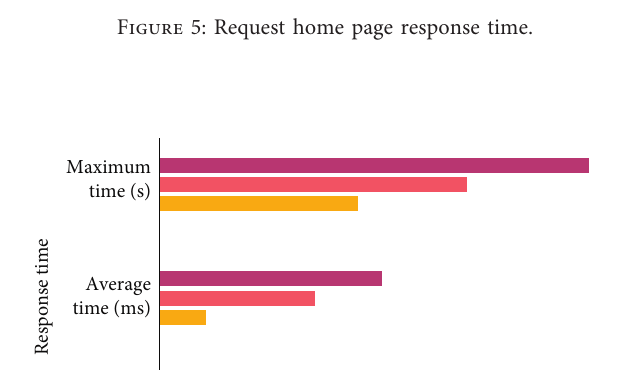
Figure 5: Request home page response time.